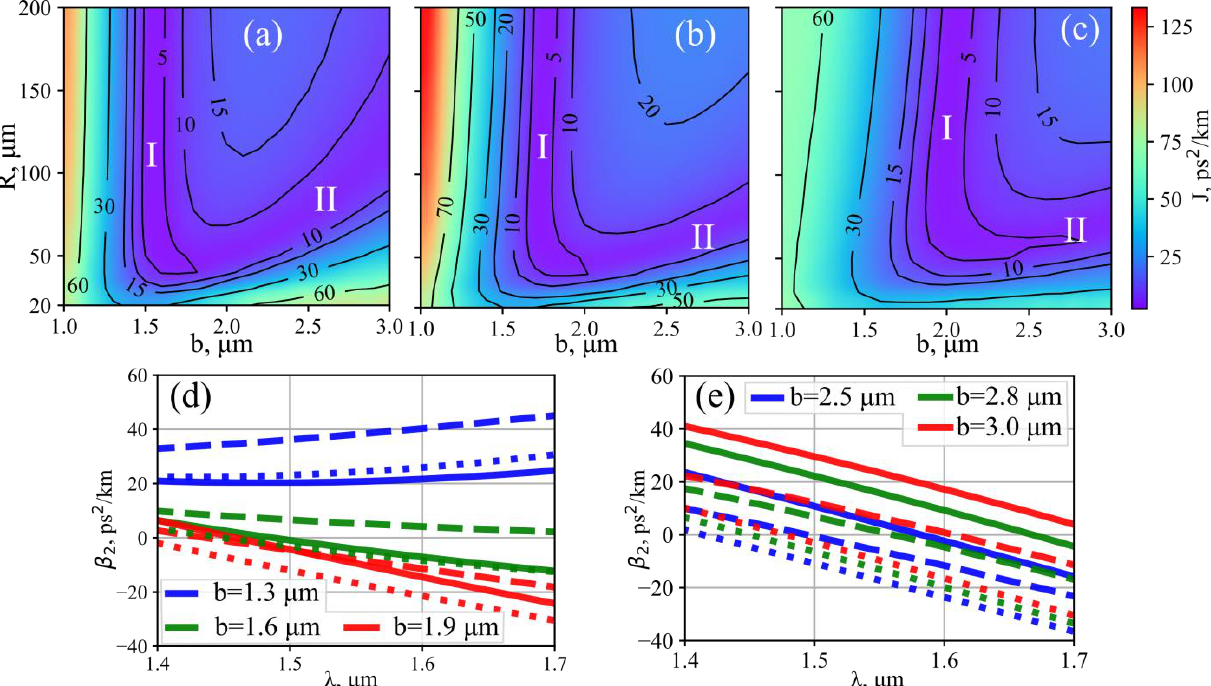
Figure 2. ( a – c ) Calculated values of the GVD deviation function J ( b , R ) for different GeO 2 content in the layer: ( a ) X = 1.0, ( b ) X = 0.5, ( c ) X = 0.2; figures ( a – c ) share the same colormap. ( d , e ) Calculated dispersion curves for different microresonator parameters: X = 1.0, R = 60 μm (solid lines); X = 0.5, R = 60 μm (dashed lines); X = 1.0, R = 160 μm (dotted lines), color legend is shown separately for ( d , e ).